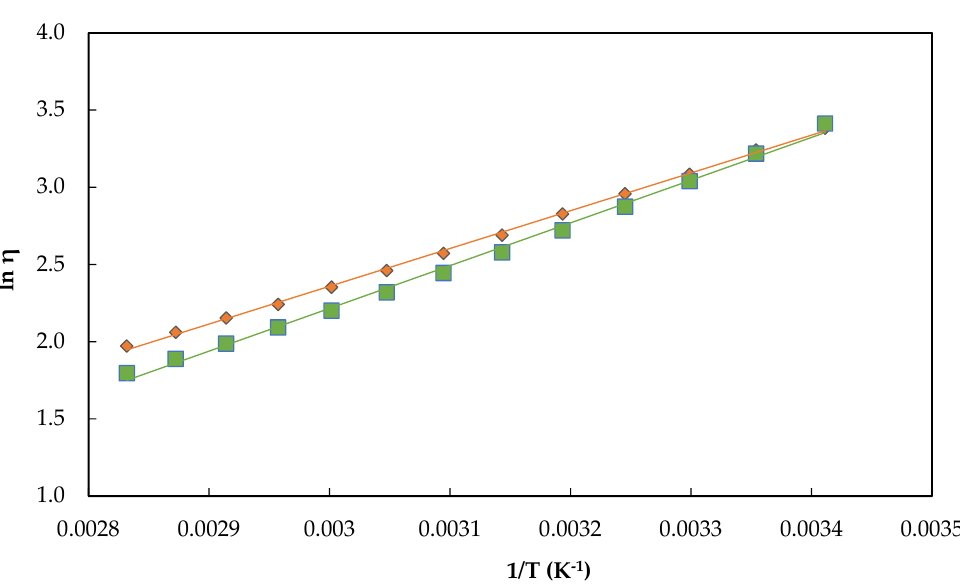
Table 2. Fitted parameters of Equation (4) for the viscosity of [C 2 mim][CF 3 BF 3 ] and [C 2 mim][CF 3 SO 2 C(CN) 2 ] with temperature.